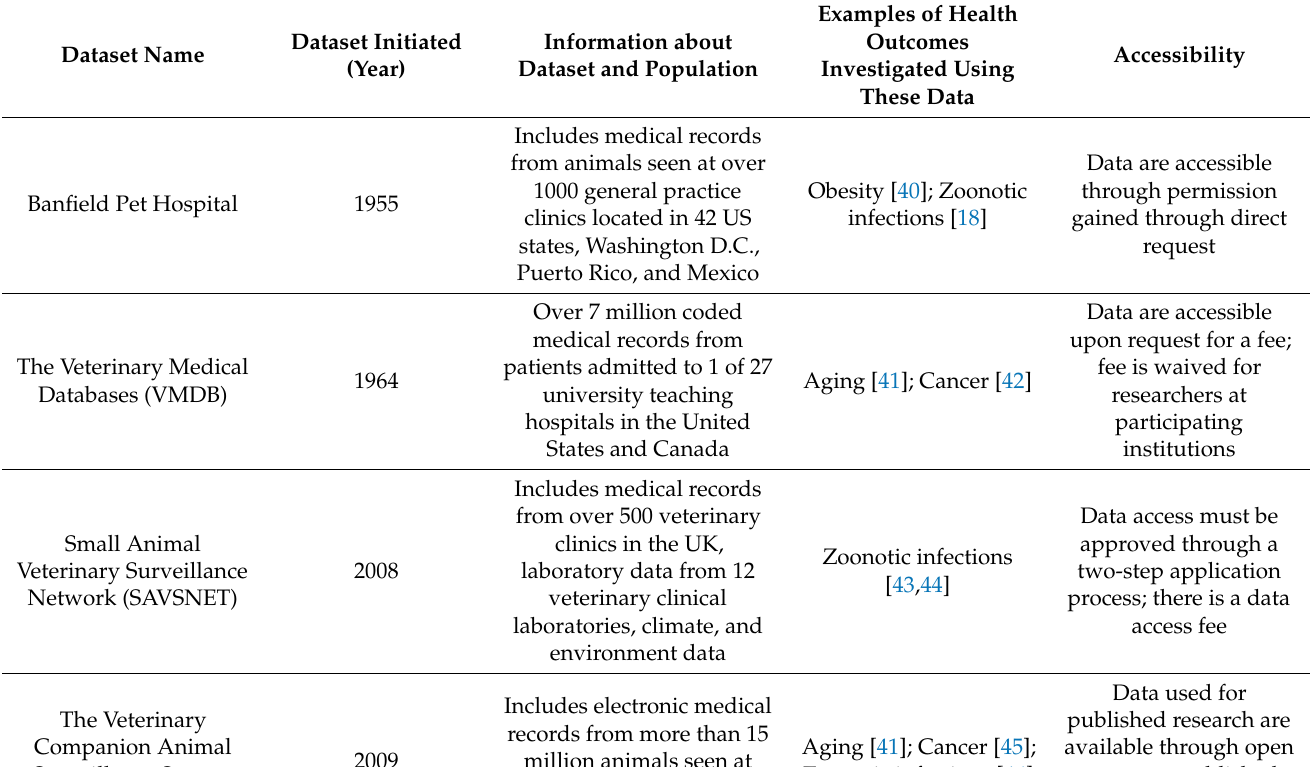
Table 1. Defining characteristics of datasets available for health research using dog